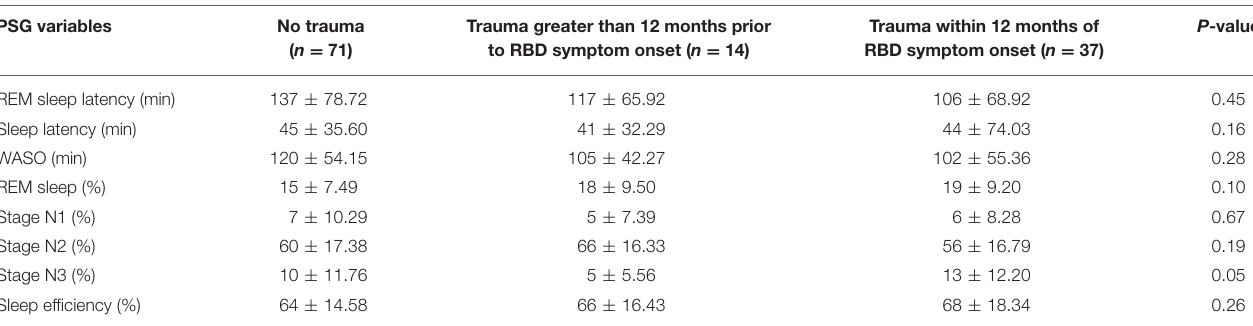
TABLE 3 | Differences in PSG variables across iRBD groups.